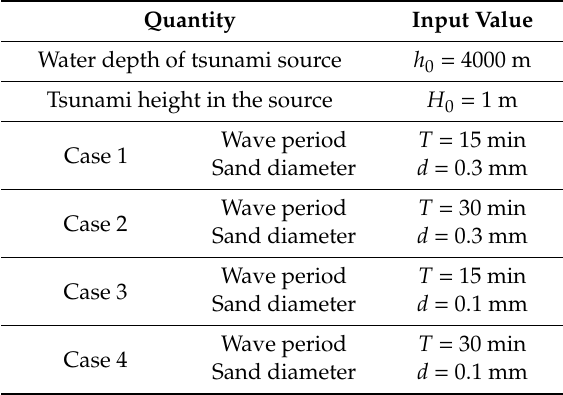
Table 1. Input tsunami